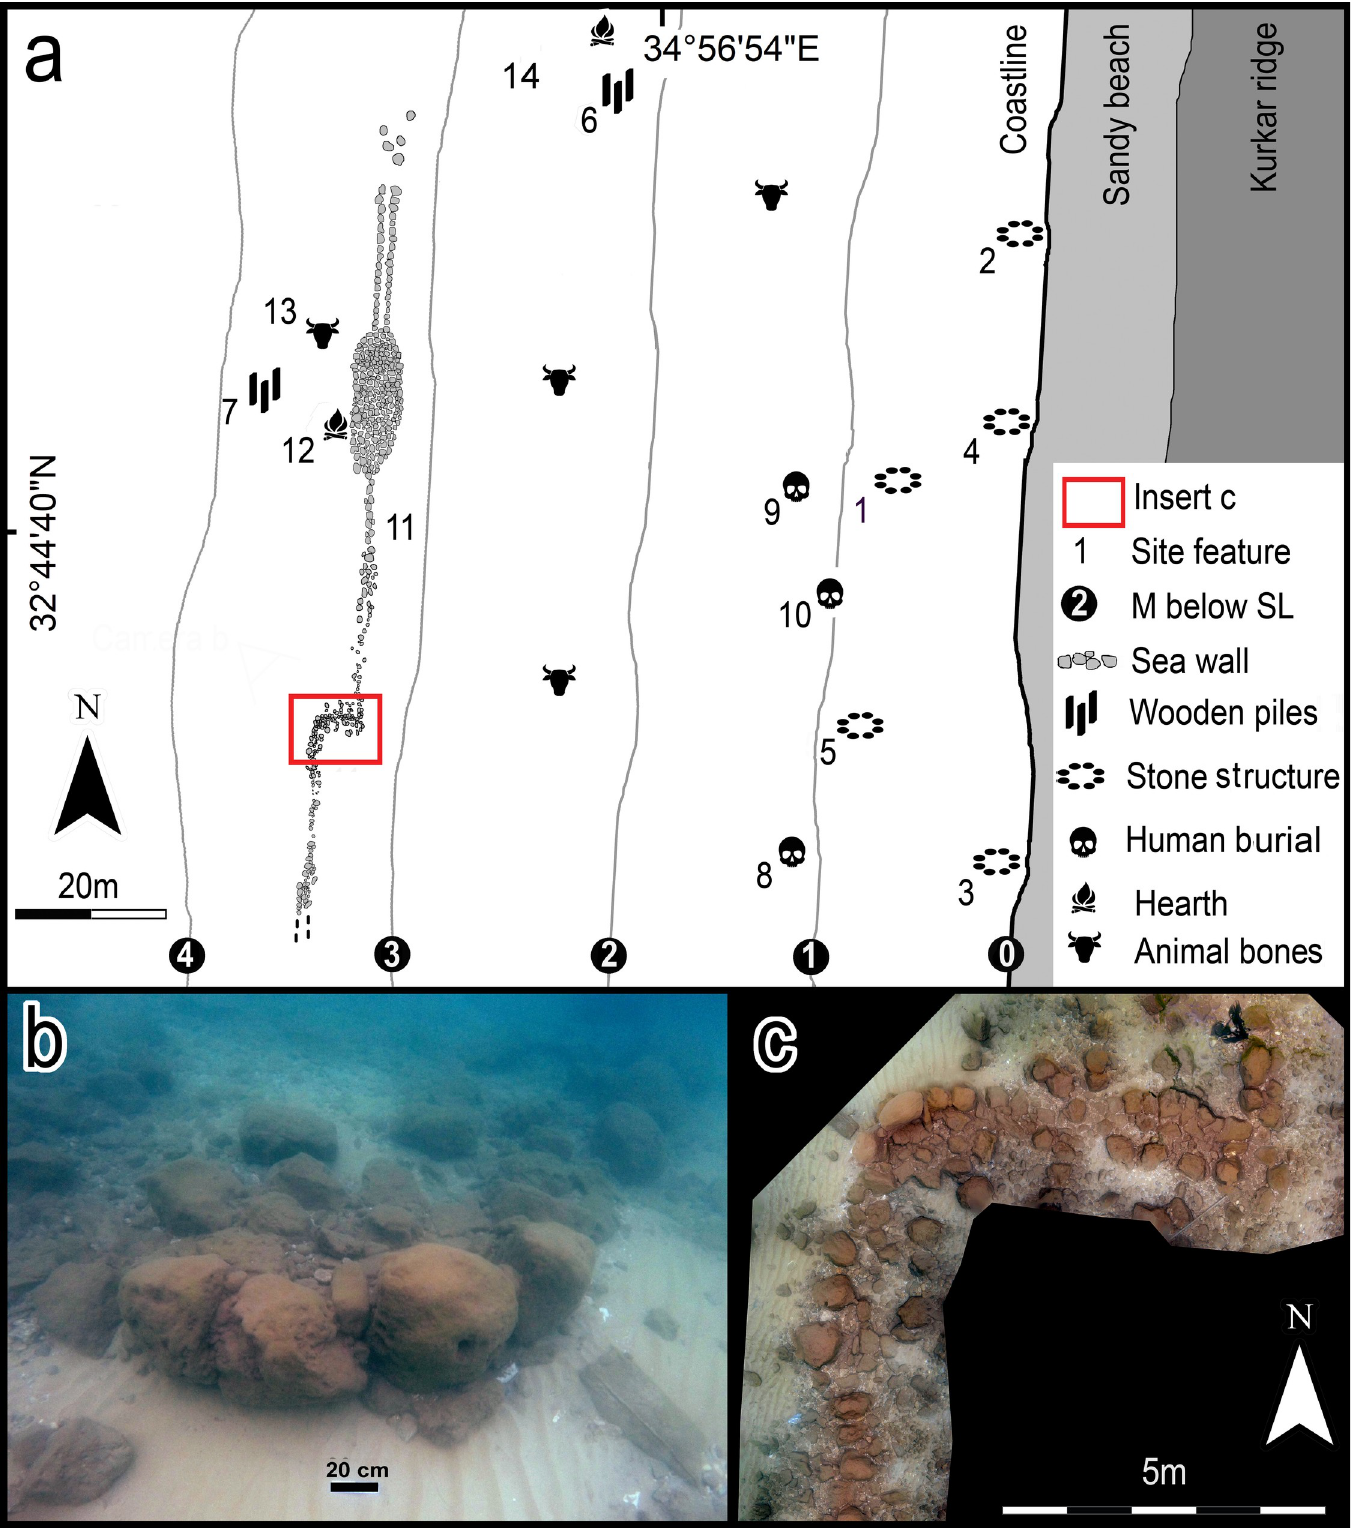
Fig 2. (a) a scale plan of the Tel Hreiz site showing location of site finds and the boulder-built seawall: (1) rectangular structure (possible dwelling). (2) two parallel wall fragments. (3) curved structure. (4-5) round structures. (6-7) concentrations of wooden posts (no. 6 was 14 C dated). (8) burial 1 ( 14 C dated). (8) burial 2. (10) stone-built